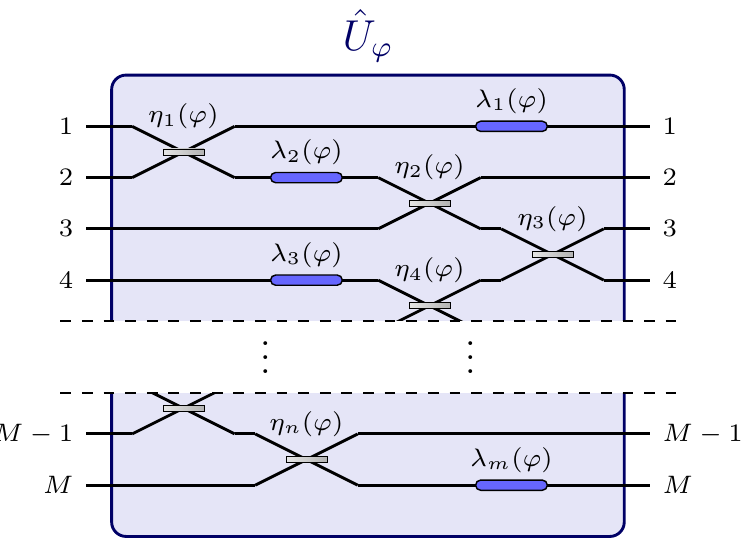
Figure 1. Example of a passive and linear network ˆ U ϕ which depends on a single global parameter ϕ [35]. The parameter can be thought as a physical property of an external agent (e.g., tempera- ture, electromagnetic field) which affects multiple components, possibly of different nature, of the network